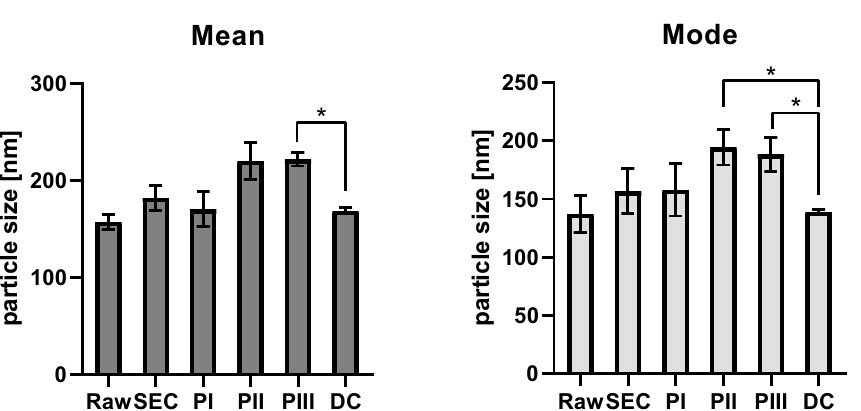
RawSEC PI PII PIII Figure 4. Analysis of mean and mode of vesicle size distribution in purified EV samples. Particle size was estimated with NTA, 3 technical replicates were registered per sample. Comparisons were made between the DC product (n = 3) and each peak of the FPLC final product (PI, PII, PIII, n = 3). * = 0.01 < p < 0.05. Data is represented as mean ±